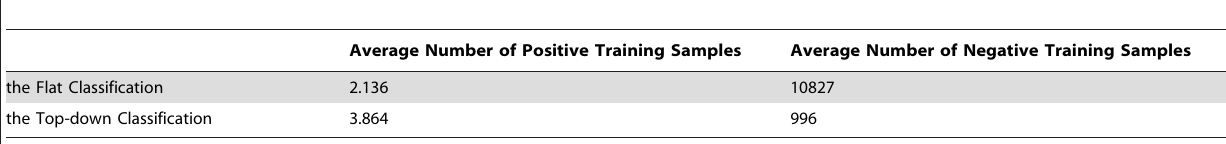
Table 1. The Comparison of Average Numbers of Positive and Negative Training